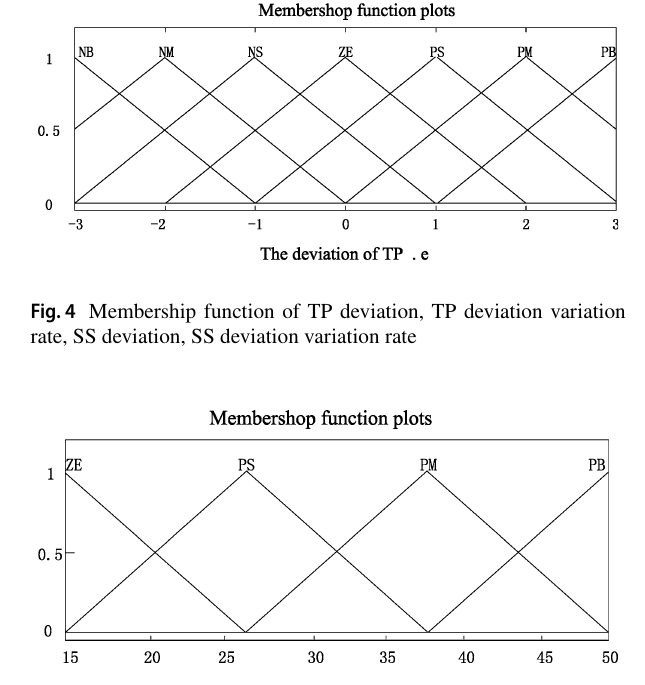
Fig. 5 PAC inverter and PAM inverter membership function